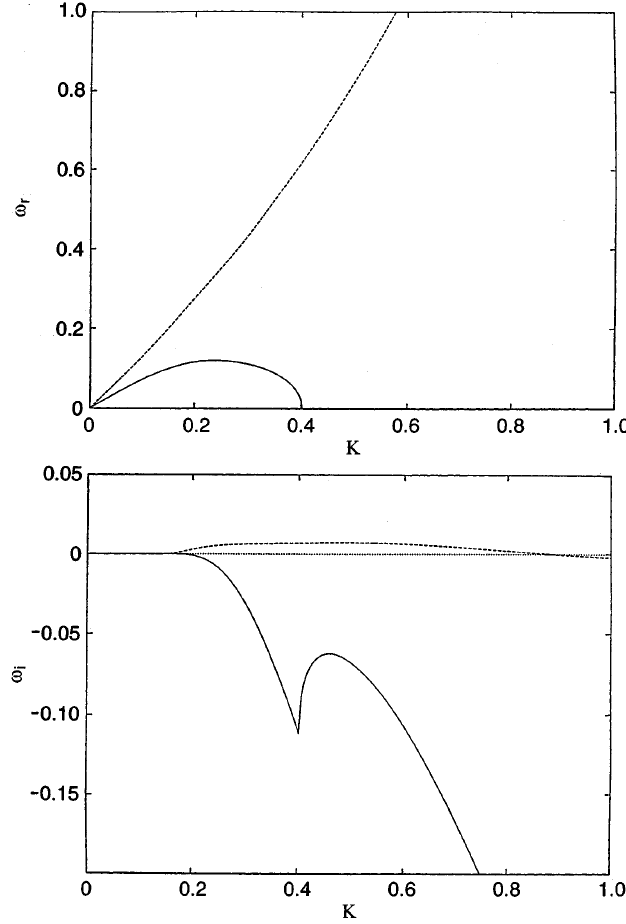
Fig. 4. Real and imaginary dispersion of the reference magnetoplas- ma when the unperturbed gyrophases of the protons and alpha particles are dichromatic. Normalizations as in